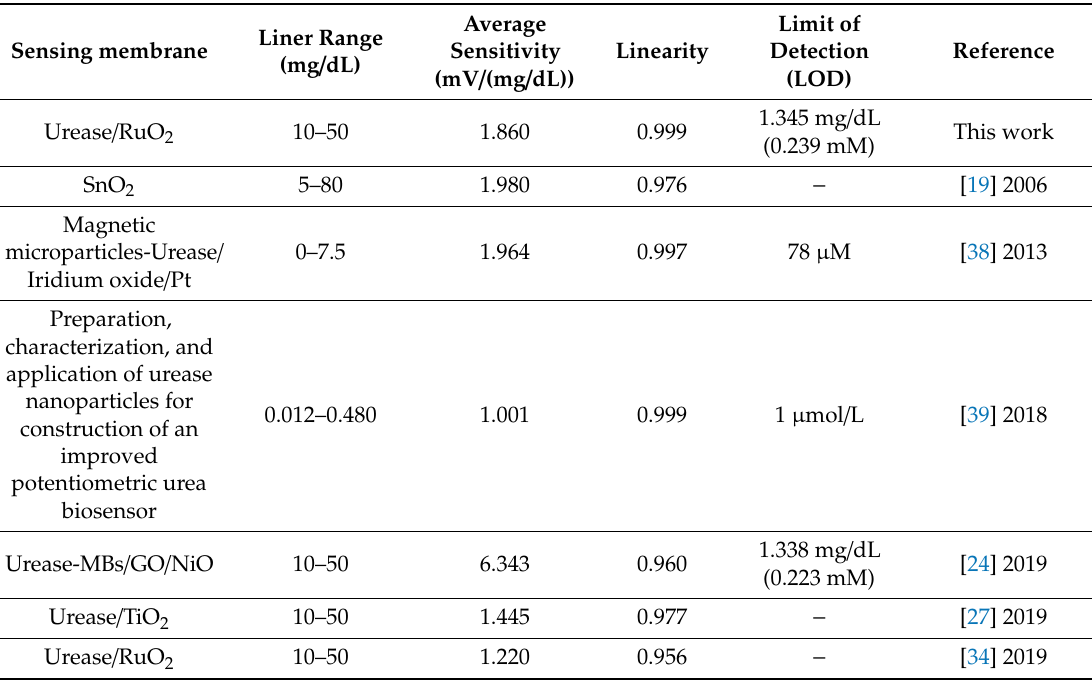
Table 2. Comparisons of the sensing properties of urea biosensors with various sensing